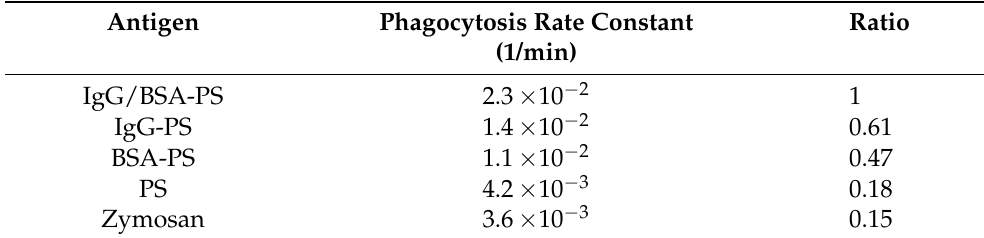
Table 1. Phagocytosis rate constants in five types of